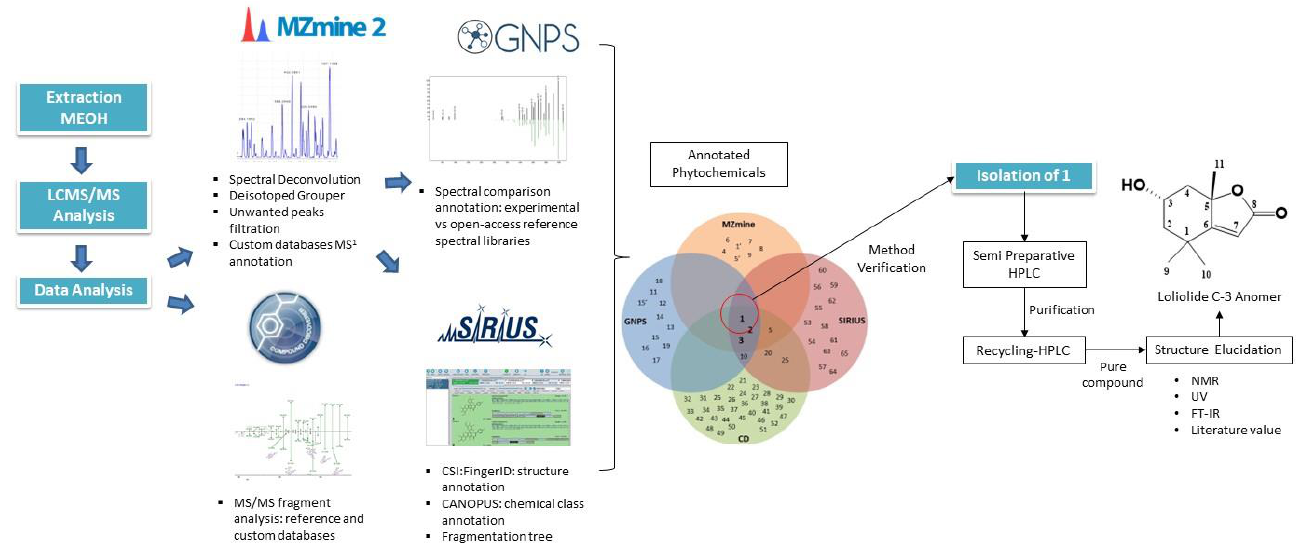
Figure 1. Infographic illustrating the annotation and identification process of phytochemicals from E. indica using high-performance liquid chromatography tandem mass spectrometry-based analy- sis.